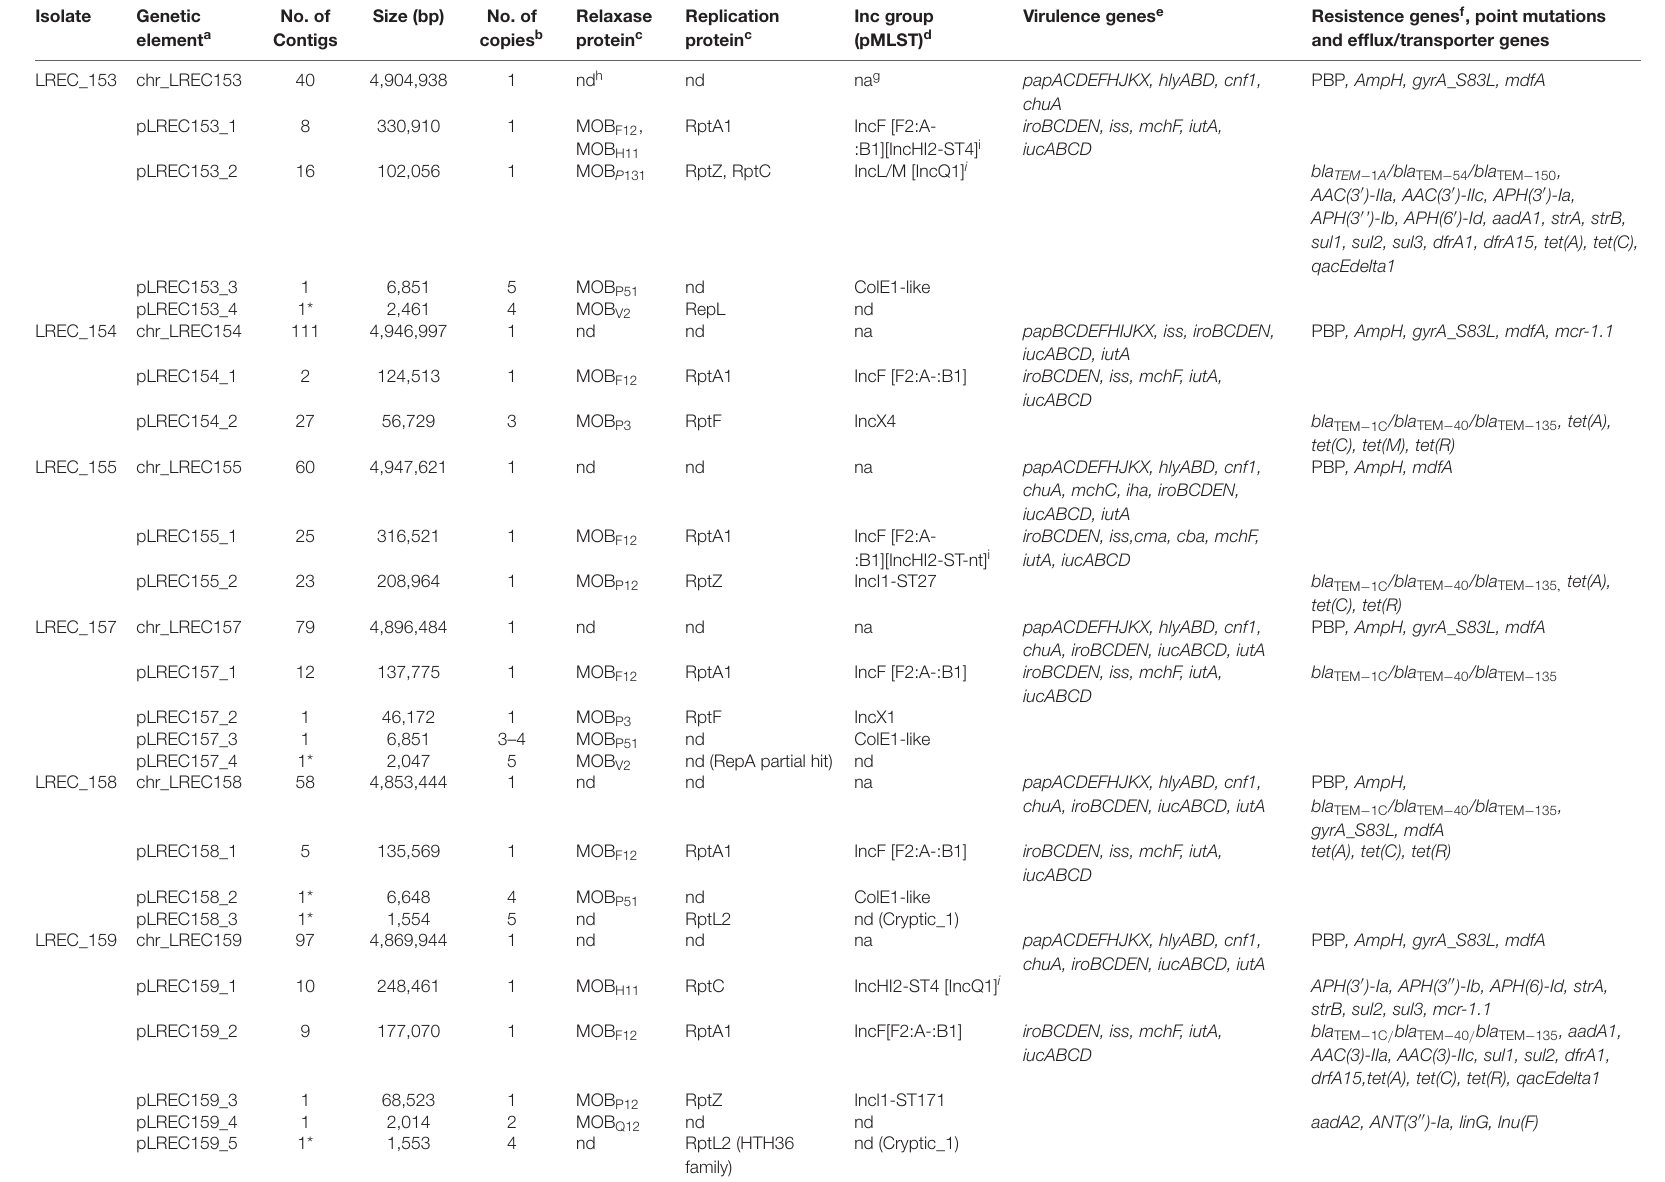
TABLE 2 | Plasmid content of the ST131 Escherichia coli isolates from porcine origin and location of resistance and virulence genes. Isolate Genetic No. of Size element a Contigs